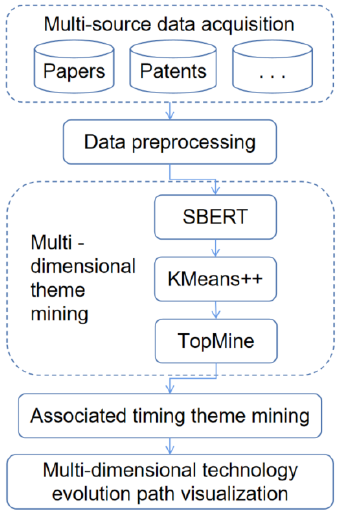
Figure 1. Method and process.